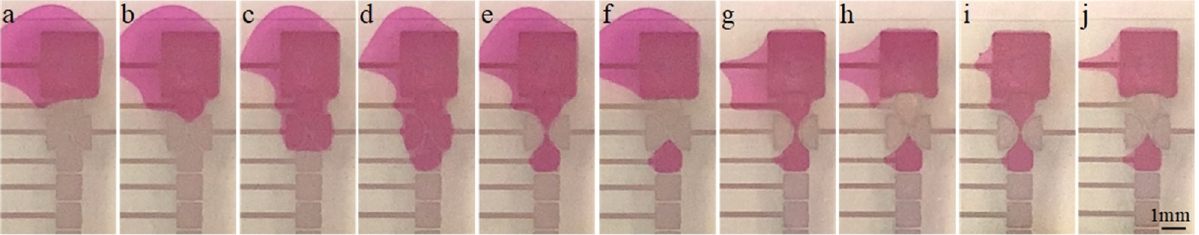
Figure 4: Series of video frames displaying the process of dispensing a droplet from a reservoir using the optimized electrodes scheme with the cutting electrodes radius R = 0.7 mm; ( a – d ) A liquid column was drawn from the reservoir as the electrodes are activated in turn; ( e ) Cutting electrodes were deactivated to form a neck; ( f ) The fi rst droplet was generated at the dispensing electrode; ( g and h ) The fi fth droplet was dispensed; ( i and j ) The tenth droplet was